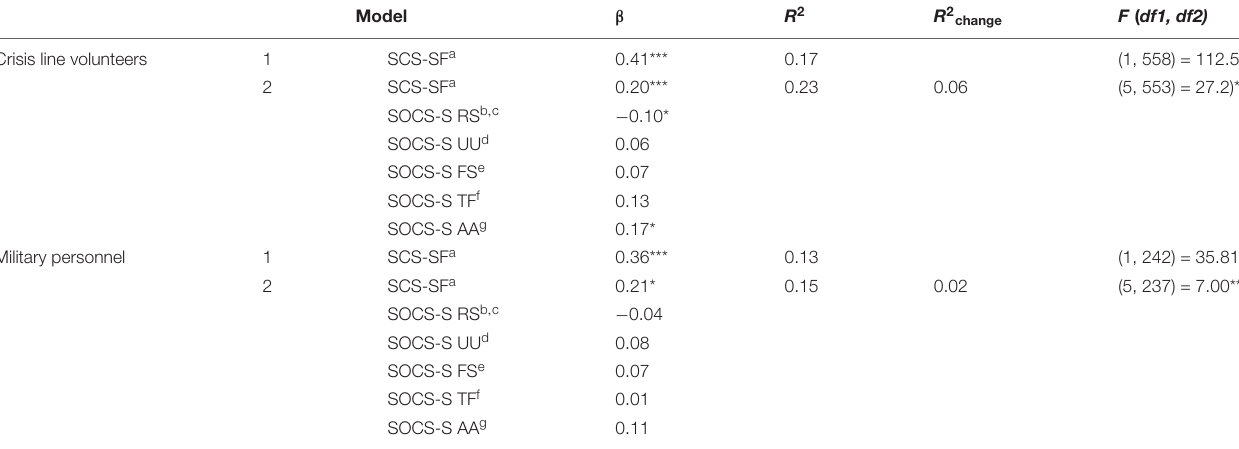
TABLE 6 | Summary of multiple regression analysis of the added value of the SOCS-S (subscales) on positive mental